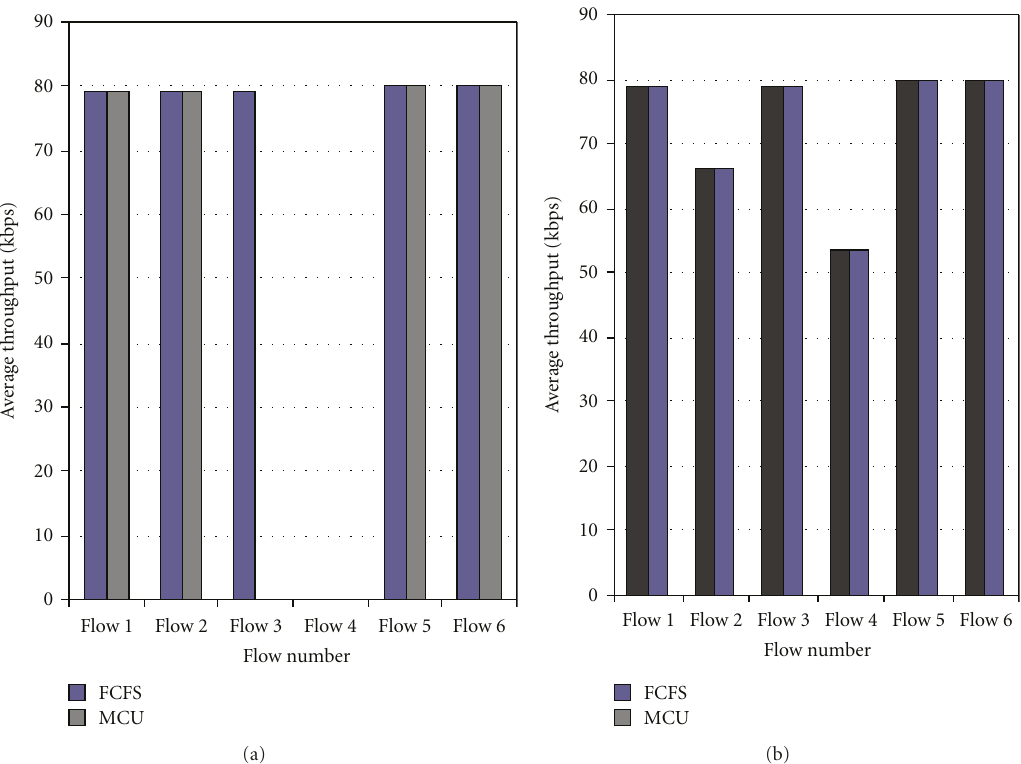
= 50%, 80% under FCFS- and MCU-based min